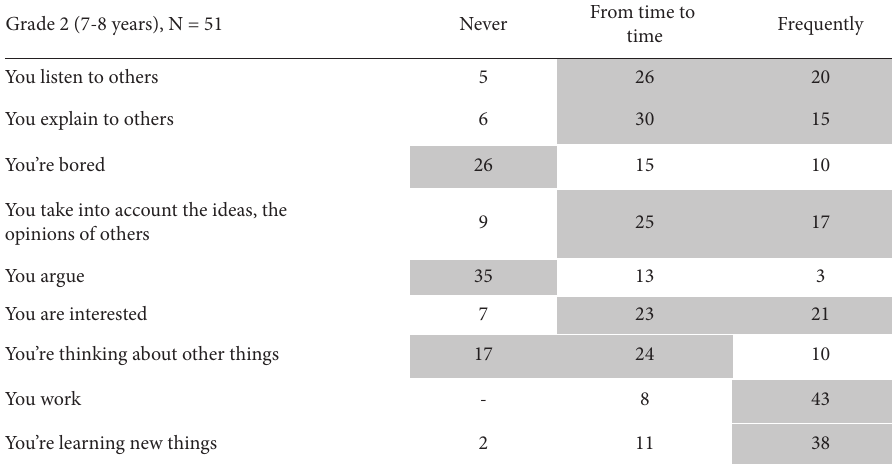
Figure 7: Breakdown of opinions among pupils in grade 1 based on how they work in a group (significance level of p � 0 .